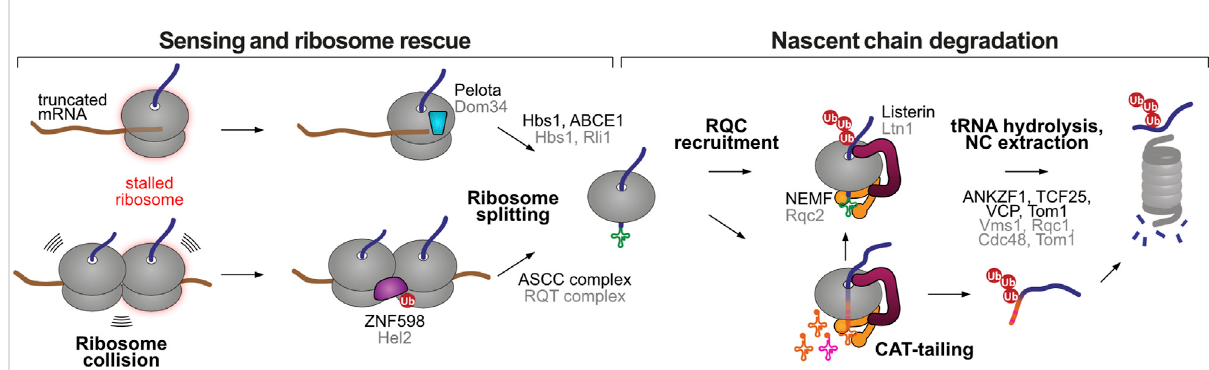
FIGURE 2 Stalled ribosome rescue and RQC pathways. Elongation-stalled ribosomes can be recognized by two mechanisms, an empty A site at the extreme3 ′ endofthemRNAorthepresenceofcollidedribosomes.Bothsituationsleadtoribosomesplitting,resultingina60Ssubunitstillattached to the peptidyl-tRNA. The RQC marks the 60S-associated nascent chain for proteasomal degradation through two possible mechanisms, Listerin- mediated ubiquitination, or NEMF-mediated CAT-tailing. The latter can promote Listerin-mediated ubiquitination or act as a degron sequence after release from the large ribosomal subunit. Homologous human and yeast factors are labeled in black and grey,